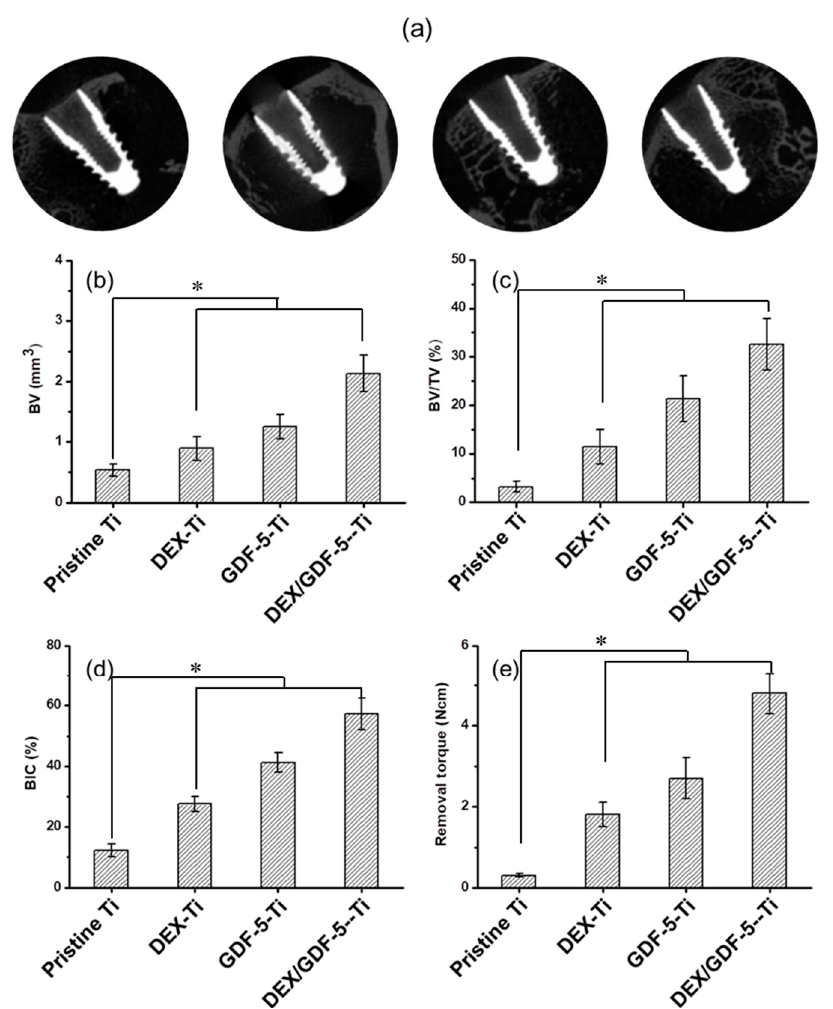
Figure 8. ( a ) Images of micro computed-tomography (micro CT); ( b ) amounts of bone volume (BV); ( c ) percentages of bone volume/tissue volume (BV/TV); ( d ) percentages of bone-implant contact (BIC) and ( e ) values of removal torque on pristine Ti, DEX–Ti, GDF-5–Ti and DEX/GDF-5–Ti screw samples after 4 weeks of implantation. The error bars represent mean ± SD ( n = 3). These experiments were repeated three times (* p < 0.05).